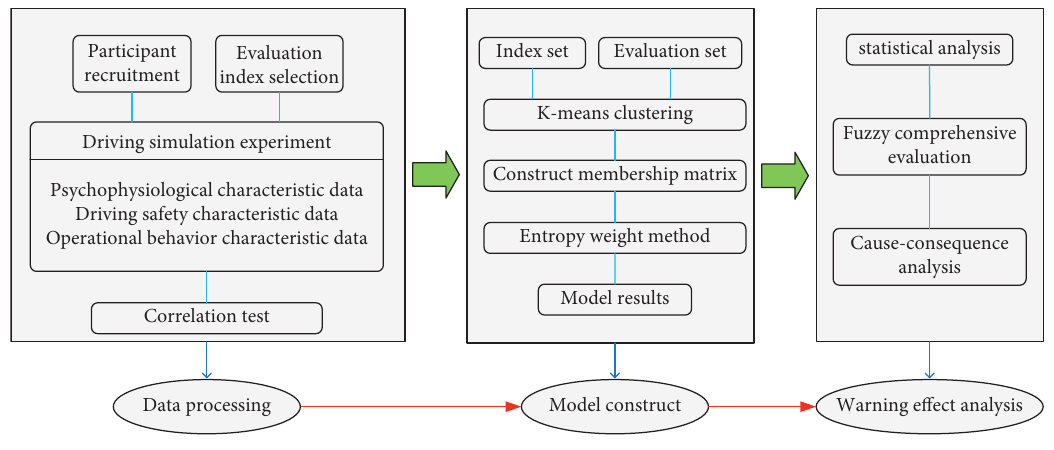
Figure 4: Study framework